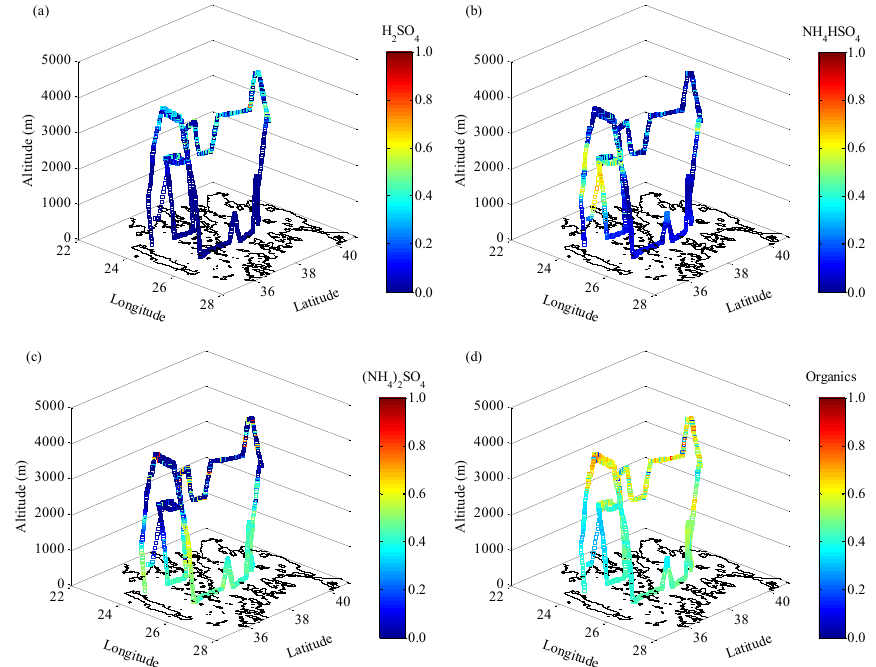
Fig. 8. Composition of the non-refractory compounds measured by the cToF-AMS during the flight performed on 4 September 2011 (flight b641) over the Aegean Sea. The reported volume fractions for H 2 SO 4 (a) , NH 4 HSO 4 (b) , ( NH 4 ) 2 SO 4 (c) and organic matter (d) are estimated using the mole fractions determined by the cToF-AMS measurements and the simplified ion pairing algorithm proposed by Gysel et al.